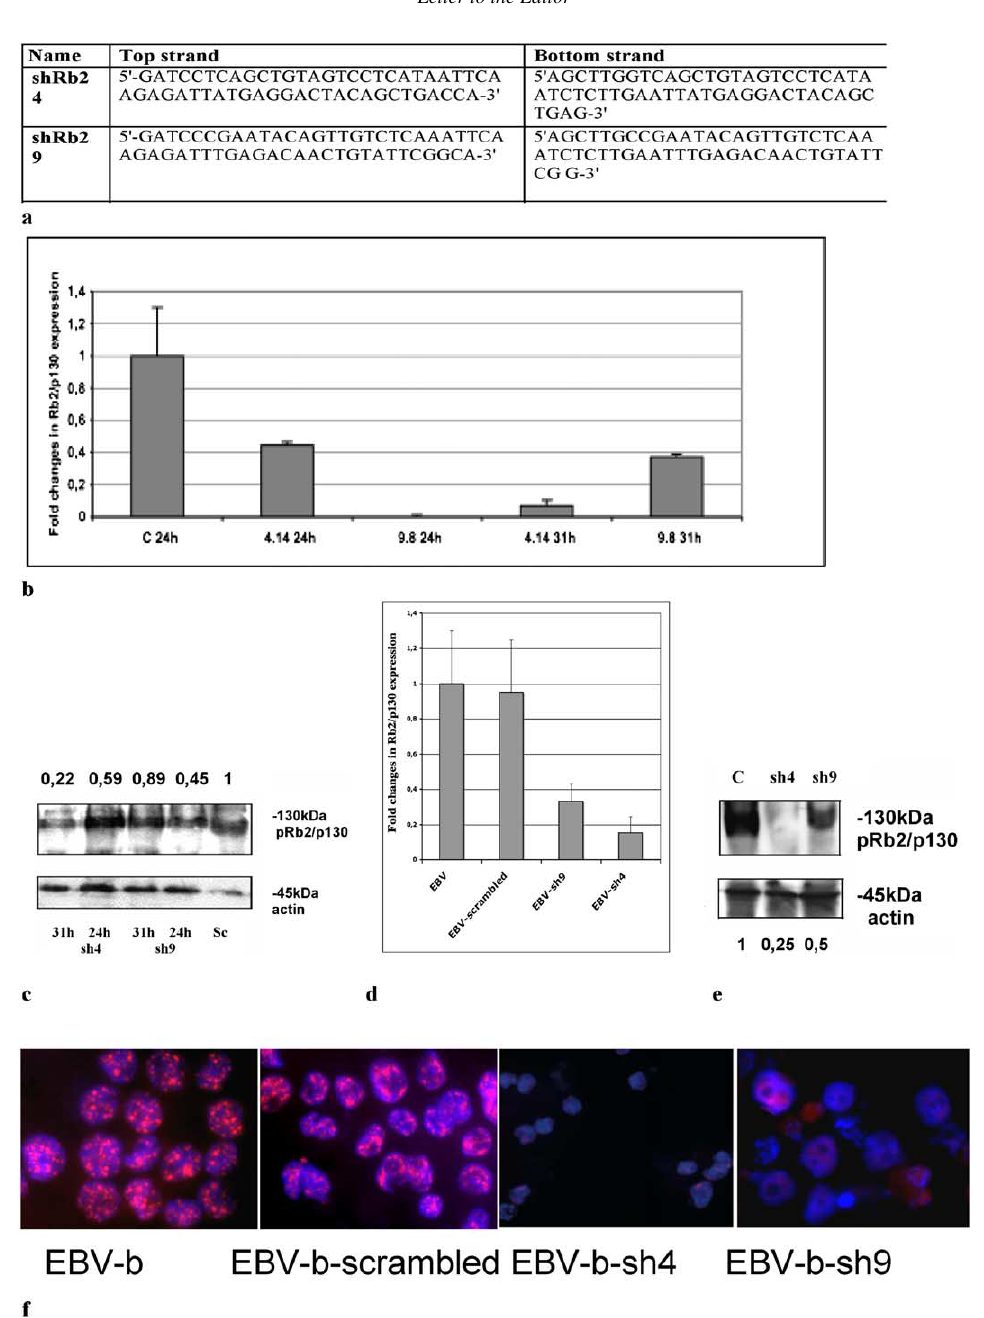
Fig. 1. a . shDNA sequences. b . pRb2/p130 expression changes during transient transfection: RB2/p130 mRNA changes in clones transiently transfected with 2 different shDNAs directed against RB2/p130. c . pRb2/p130 levels after transient transfection: pRb2/p130 protein levels in control scrambled sequence (SC) or cells transfected with sh4 or sh9 respectively 24 and 31 hours after transfection. Levels of pRb2/p130 in scrambled transfected cells did not change between 24 and 31 hours (data not shown). Densitometry was shown on the top of the panel. d . Rb2/p130 expression during stable short hairpin transfections: RB2/p130 mRNA changes in clones transfected with sh4 and sh9 compared with EBV-b untransfected control (C). e . pRb2/p130 levels during permanent expression: pRb2/p130 protein levels in control scrambled sequence (SC) or cells that stably express sh4 or sh9. Densitometry was shown at the bottom of the panel. f . Visualization of pRb2/p130 by immunofluorescence: DAPI staining (blue) shows nuclei. Alexafluor568 staining (red) shows pRb2/p130 localization. pRb2/p130 decreases in sh4 and sh9 expressing cells was evident. Scrambled-expressing cells did not show any significant change in pRb2/p130 expression or